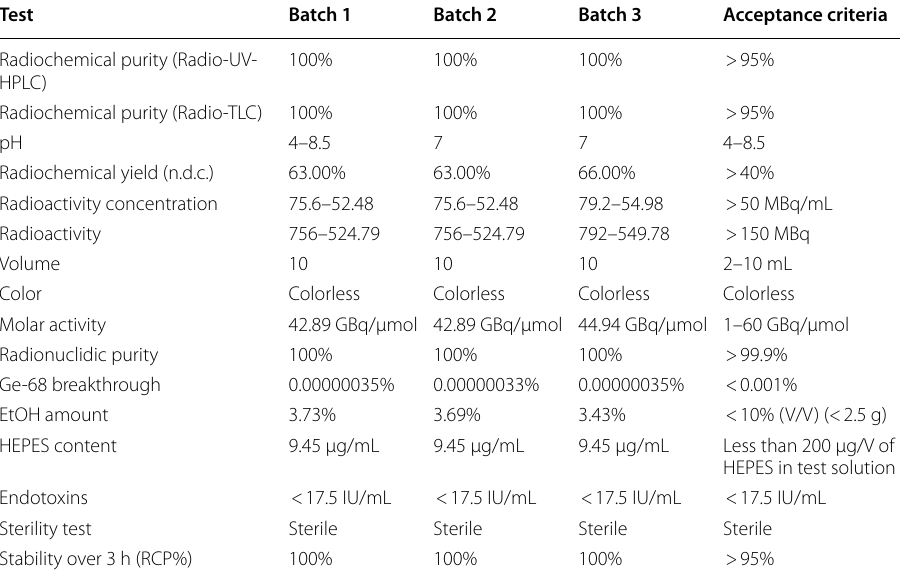
Table 2 Summary data of three consecutive validation batches of [68Ga]68Ga-DOTA-ECL1 (20 μg)